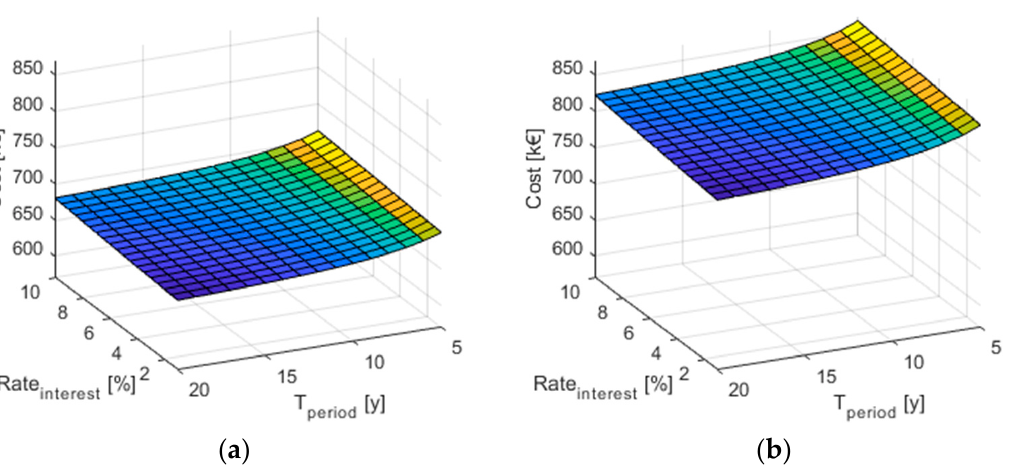
Figure 12. Minimum annual total cost for the best solution for power plant with full redundancy: ( a ) without reliability considerations; ( b ) minimum annual total cost for the best solution with reliability considerations.